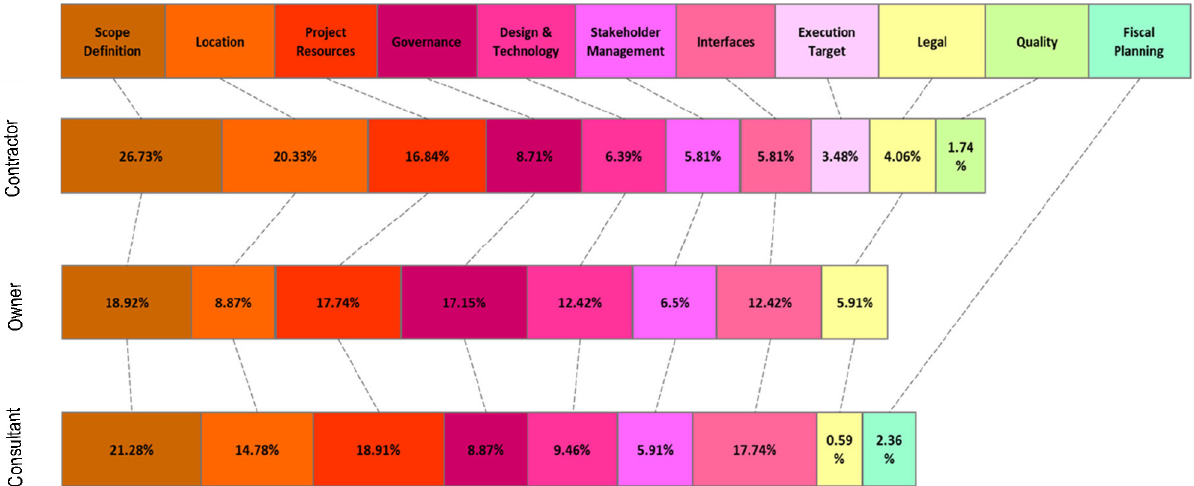
Figure 5. Comparison of entity-based weighting of complexity categories